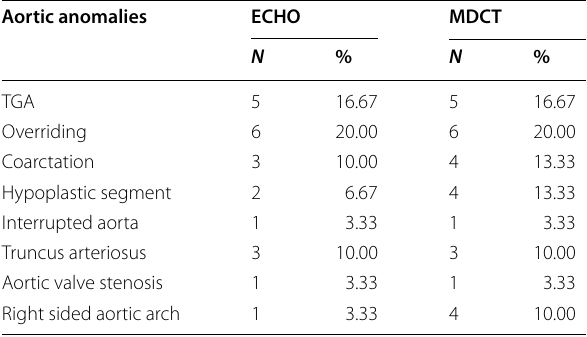
Table 5 Aortic anomalies detected by Echocardiography and MDCT angiography